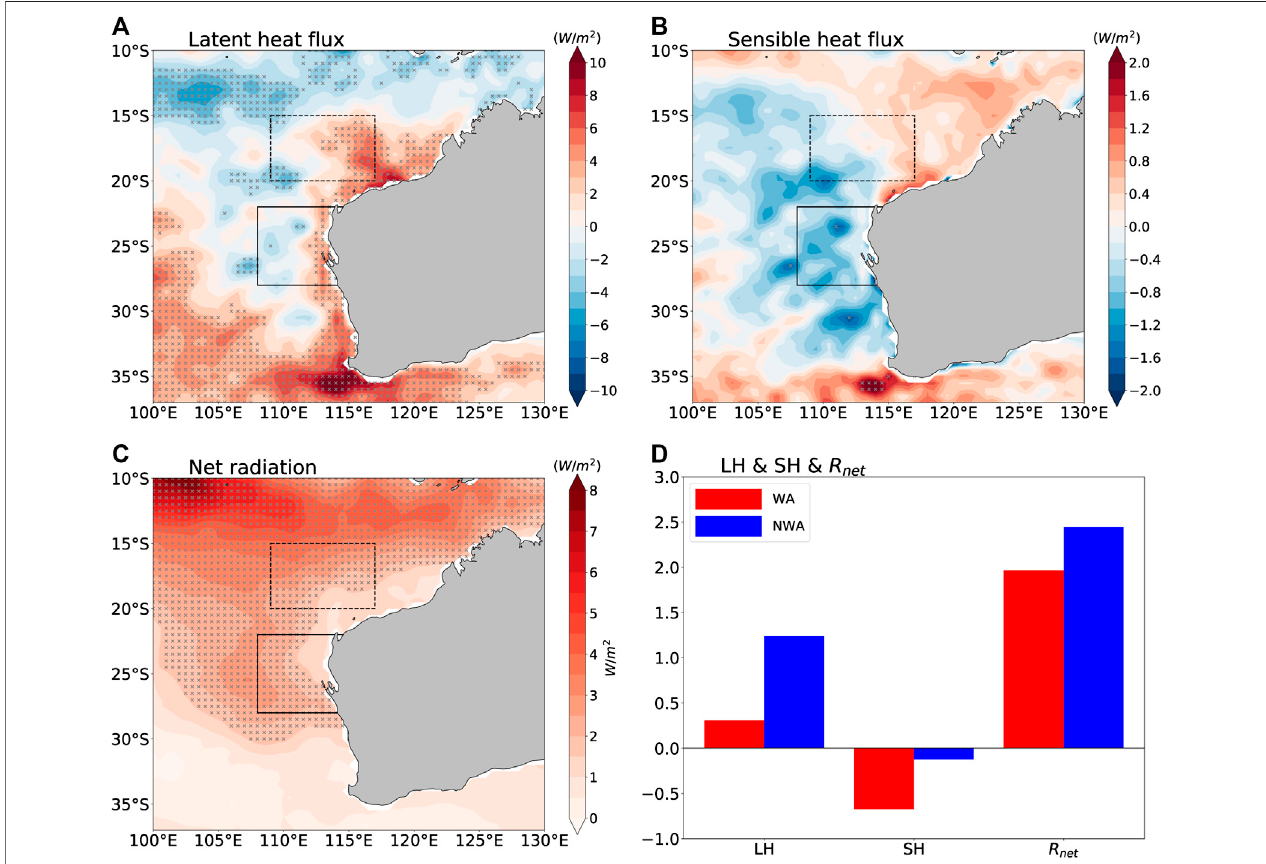
FIGURE9| Linearregressionsoftheaustralsummer(DJF)mean (A) latentheat fl ux(W m − 2 ), (B) sensibleheat fl ux(W m − 2 ),and (C) netradiativeheatingrateofthe entire atmosphere (W m − 2 ) during 1981 – 2018. The gray crosses indicate the variable anomalies above the 90% signi fi cance level by a Student t test. The solid and dashed boxes indicate the WA (108 ° E-coast, 28 – 22 ° S) and NWA (109 – 117 ° E, 20 – 15 ° S) coastal regions, respectively. (D) Latent heat fl ux, sensible heat fl ux and net radiative heating rate terms averaged over the NWA (blue bars) and WA (red bars) coastal regions.